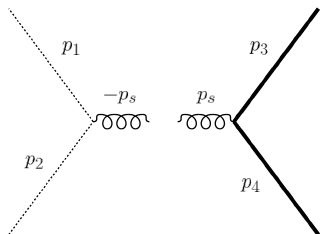
Figure 1: DM pair production in the gravity-mediated scenario. The thick line is the spin- S DM, the dotted line is a SM particle and the curly line is the graviton. All momenta are incoming, and p